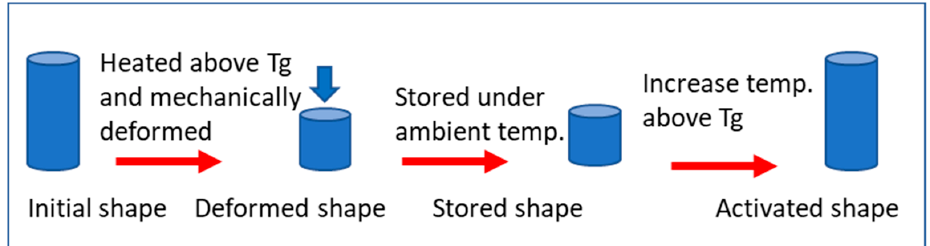
Figure 1. Thermo-mechanical cycle steps performed on shape memory materials.